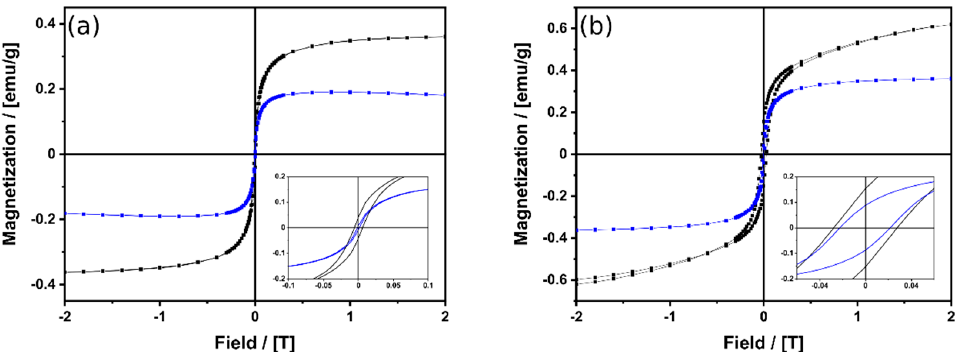
Figure 3. Superconducting quantum interference device (SQUID) measurement at ( a ) 300 K and ( b ) 4 K of Mag@PSS templates (blue curve) and the resulting gradient porous Mag@C material (black curve), with respective inlets showing the hysteresis region.